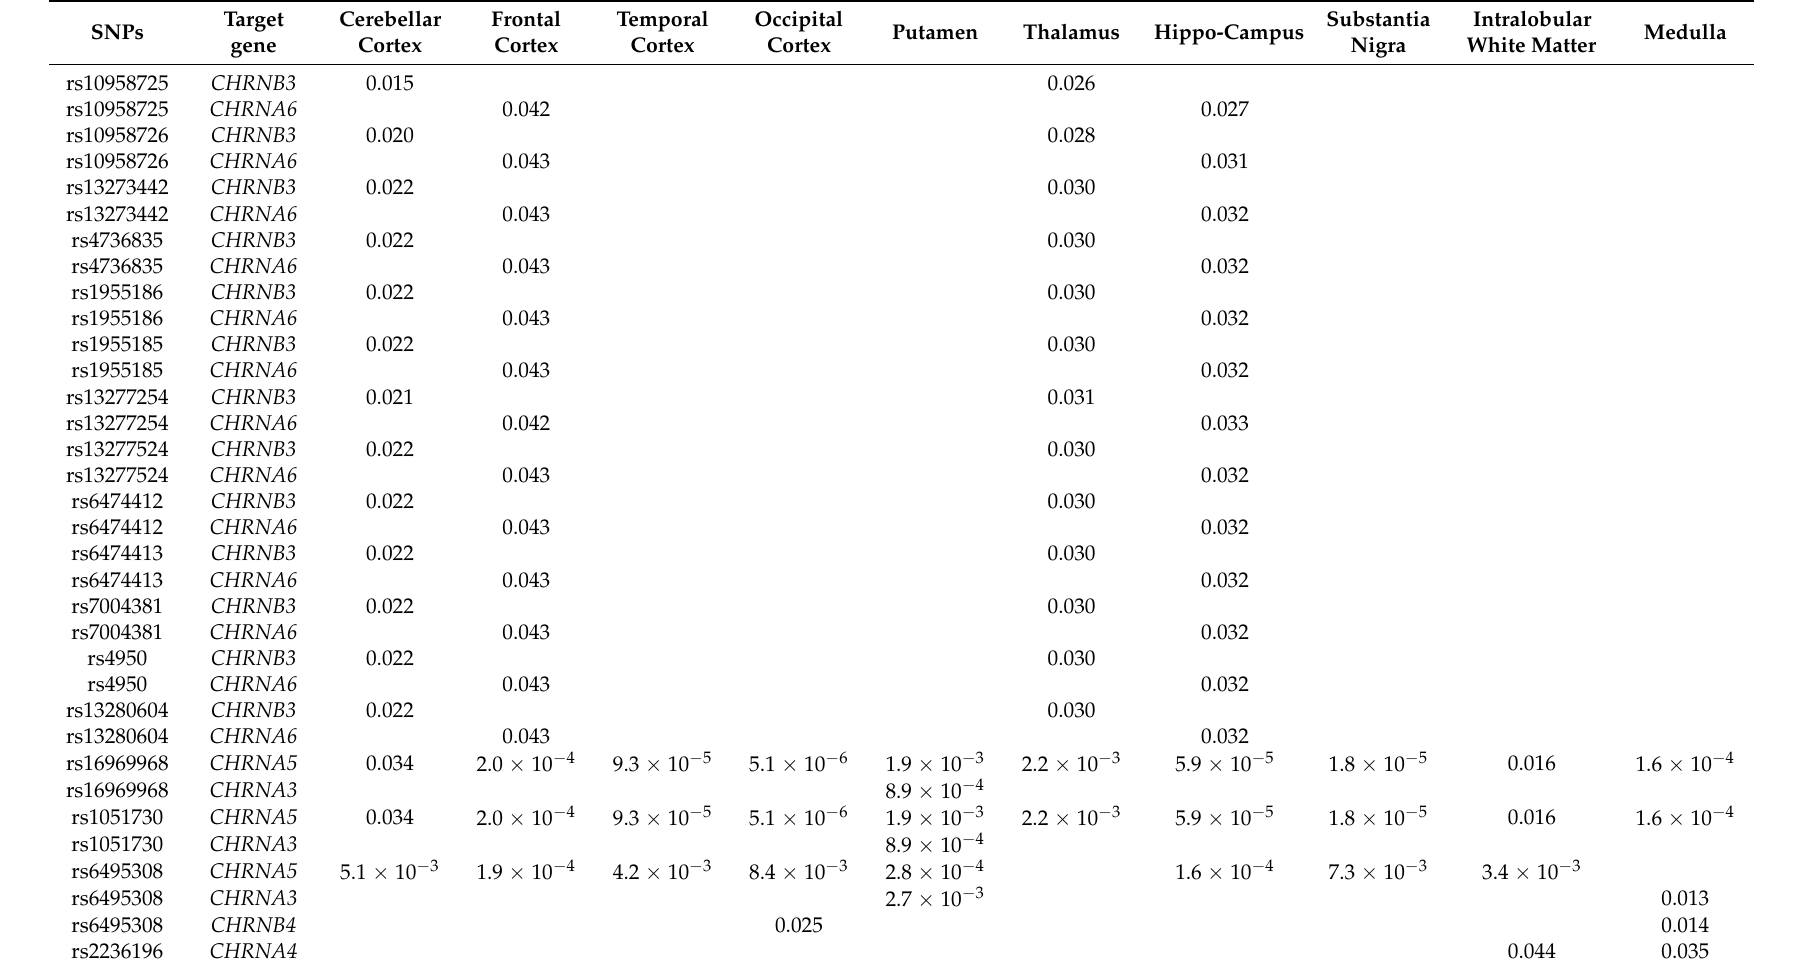
Table 4. Cis -acting expression of quantitative locus ( cis -eQTL)